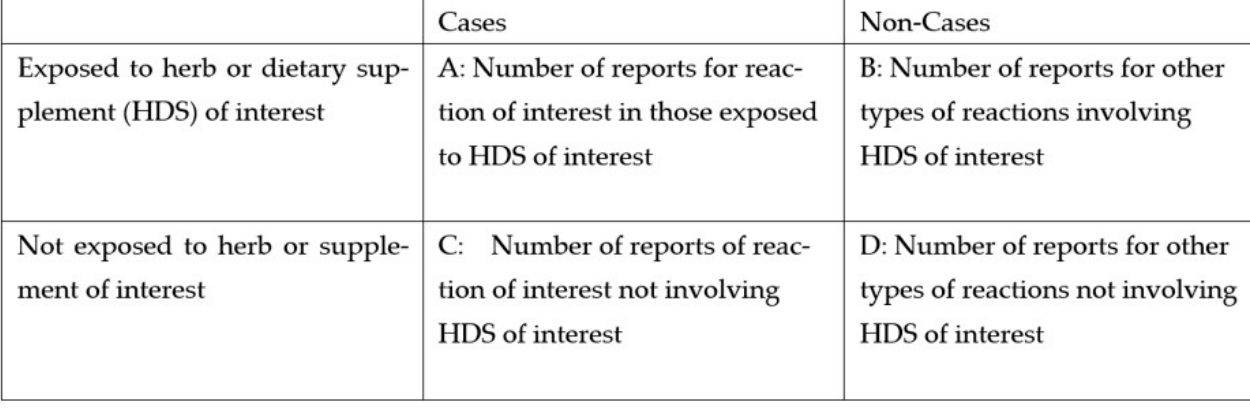
Figure 5. Method of calculating reporting odds ratio (ROR) and confidence